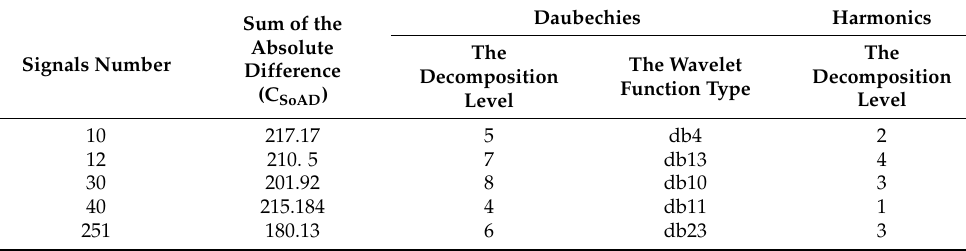
Table 3. C SoAD evaluation criterion performance